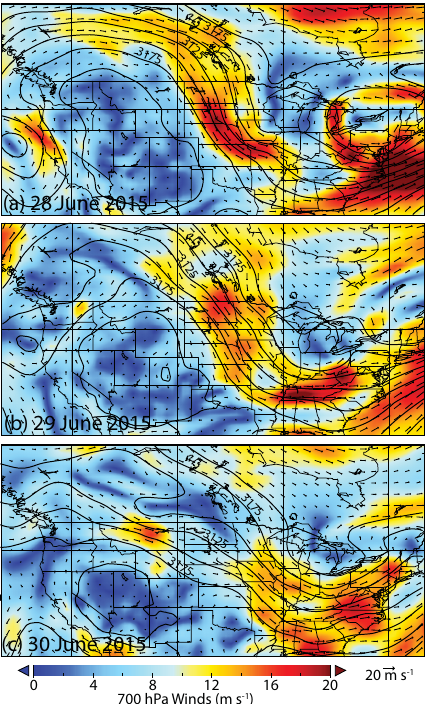
Figure 4. ECMWF Reanalysis of 700hPa geopotential heights overlayed on winds for (a) 28, (b) 29, and (c) 30 June 2015 at